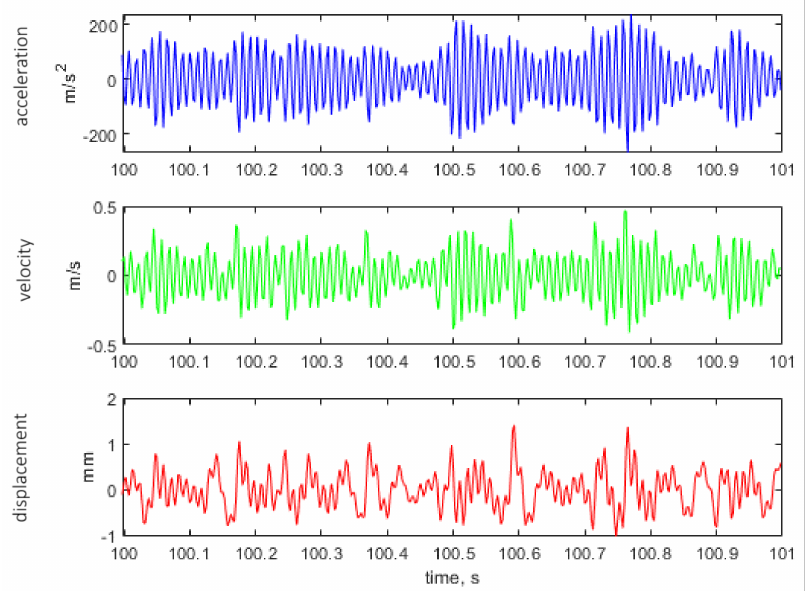
Figure 13. Representative time histories of acceleration measured on additional mass (see Figure 4) and the calculated velocity and displacement for the excitation signal with kurtosis parameter Ku =